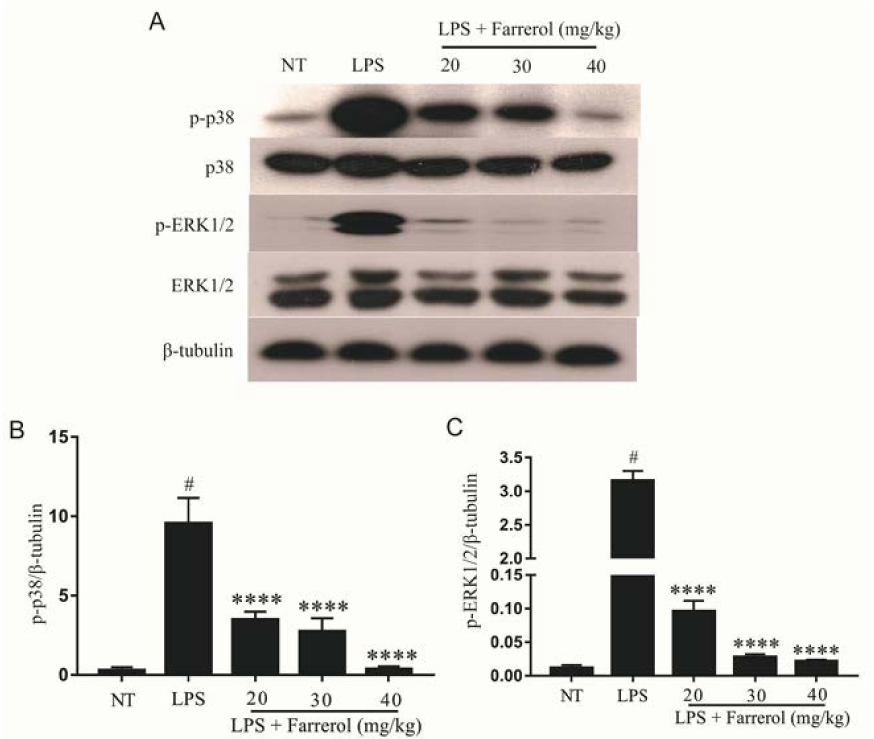
Figure 6. Farrerol inhibited the phosphorylation of ERK1/2, p38 in LPS-induced mouse mastitis. The phosphorylation of p38 ( A , B ) and ERK1/2 ( A , C ) were measured by Western blot. Data are presented as mean ± SEM ( n = 3). # p < 0.05 vs. NT group; **** p < 0.0,001 vs. LPS group.